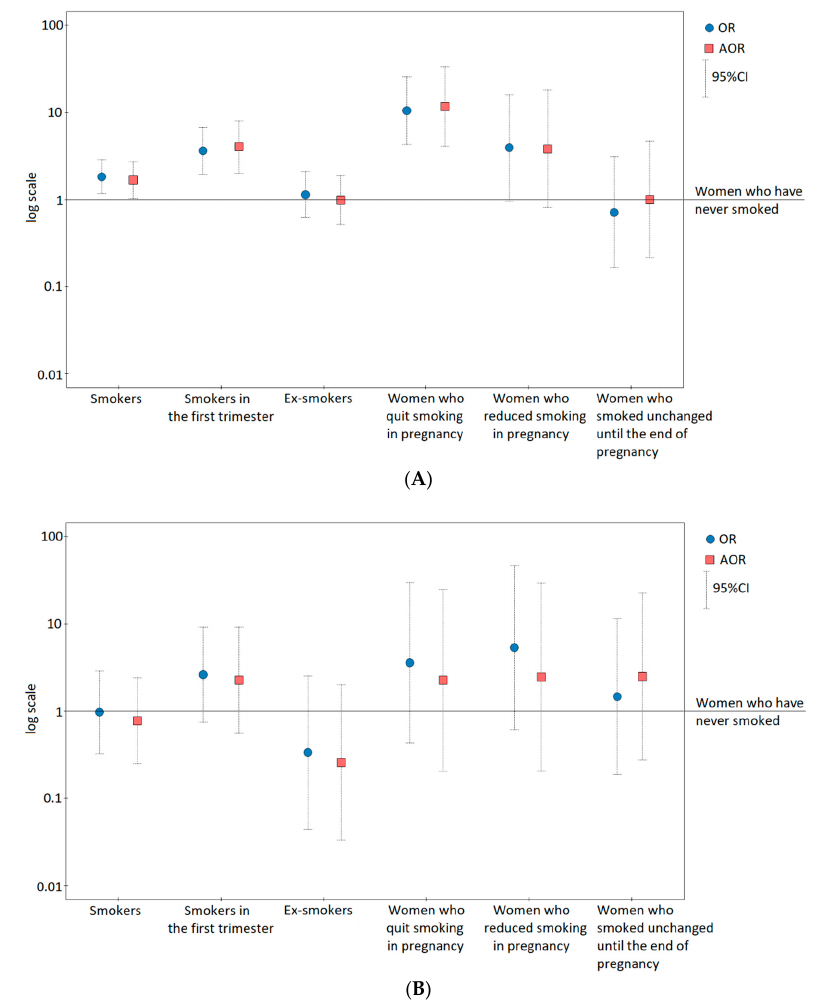
Figure 1. Odds ratios (and 95% confidence intervals) of gestational hypertension ( A ) and pre-eclampsia ( B ) for smoking categories on a logarithmic scale. The adjusted odds ratios (AOR) were calculated after adjusting for maternal age, primiparous women, pre-pregnancy body–mass index (BMI), and gestational weight gain outside the range of the recommendations regardless of the BMI category.